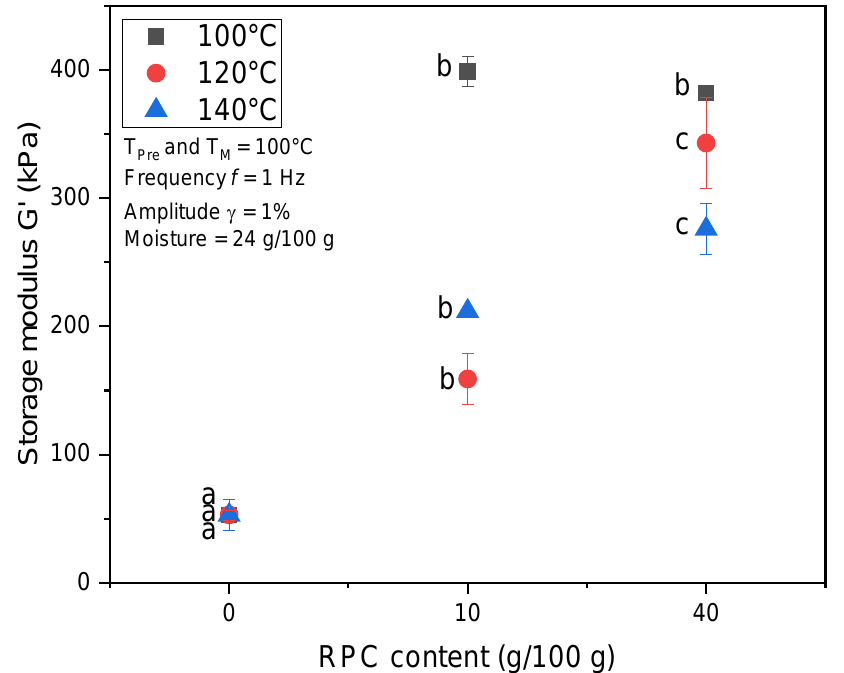
Figure 6. Storage modulus G‘ (kPa) after 1 min treatment time (T T ) as a function of rapeseed press cake (RPC) content (0, 10 or 40 g/100 g (w.b.)) and barrel temperature (T Barrel = 100, 120, 140 ◦ C) of extruded maize starch (MS) blends. Samples extruded and rehydrated to 24 g/100 g (d.m.) moisture content; pre-treatment and measurement temperature (T Pre , T M ) 100 ◦ C. Mean values with different superscript letters indicate significant differences ( p < 0.05) based on a one-way analysis of variance (ANOVA). Means were compared using Tukey’s honest significance test. Table 2. Extruder response parameters (pressure at the die, product temperature, torque and specific mechanical en- ergy input (SME)) as a function of barrel temperature (T Barrel = 100, 120, 140 ◦ C) of maize starch (MS) blended